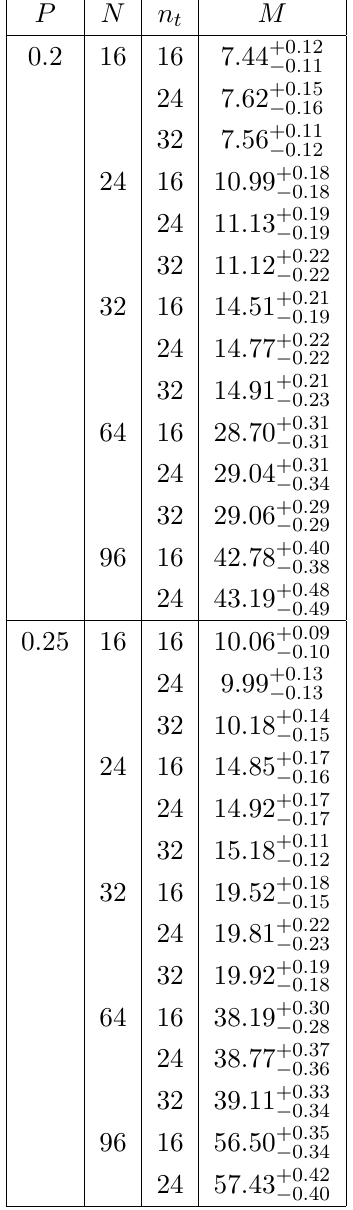
Table 1. P vs M at T = 0 . 29 . The central value of M is the median of the posterior predictive distribution. The lower and upper bound are the 16 % and 84 % quantiles,